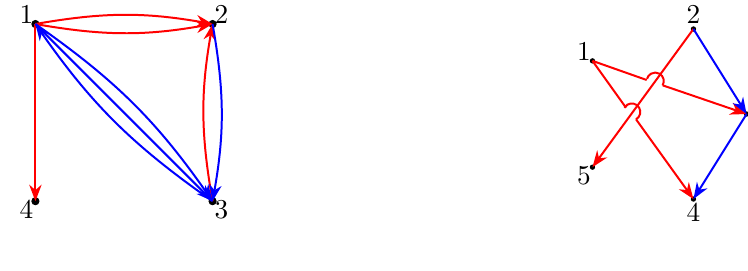
Figure 2 . The graph associate to the kinematic structures h 1 2 i 2 h 1 4 ih 3 2 i [2 3][1 3] 2 [3 1] and h 1 3 ih 1 4 ih 2 5 i [2 3][3 4] respectively.